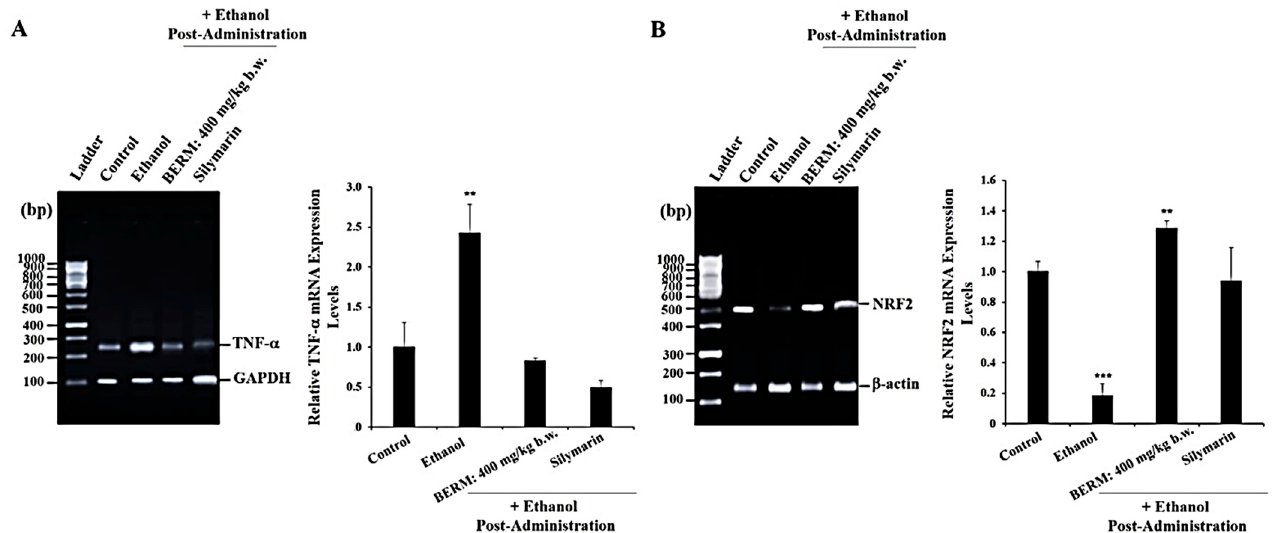
Figure 2. BERM pre-administration decreased ethanol-induced TNF- α mRNA expression levels and upregulated ethanol-suppressed NRF2 mRNA expression levels. Representative gel electrophoresis showing mRNA expression levels of ( A ) TNF- α and the internal control glyceraldehyde 3-phosphate dehydrogenase (GAPDH), and ( B ) NRF2 and the internal control β -actin, determined by RT-PCR analysis in the control mouse group, ethanol-treated group, BERM, or Silymarin administration prior to ethanol injection. The bar graphs show the expression levels of TNF- α mRNA related to GAPDH and of NRF2 related to β -actin . The data are presented as the mean ± standard deviation (SD) of three independent experiments. ** p < 0.01 and *** p < 0.001 vs. Control.